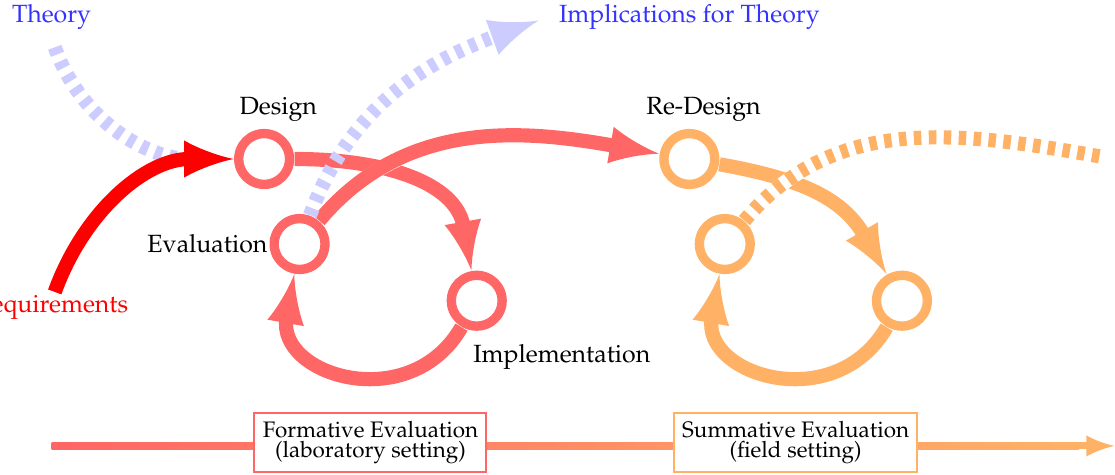
Figure 2. Visualizing the process of Design-Based Research orientied to [30] specified for our research project. This figure serves as a structuring element both for (a) our research project in general, and